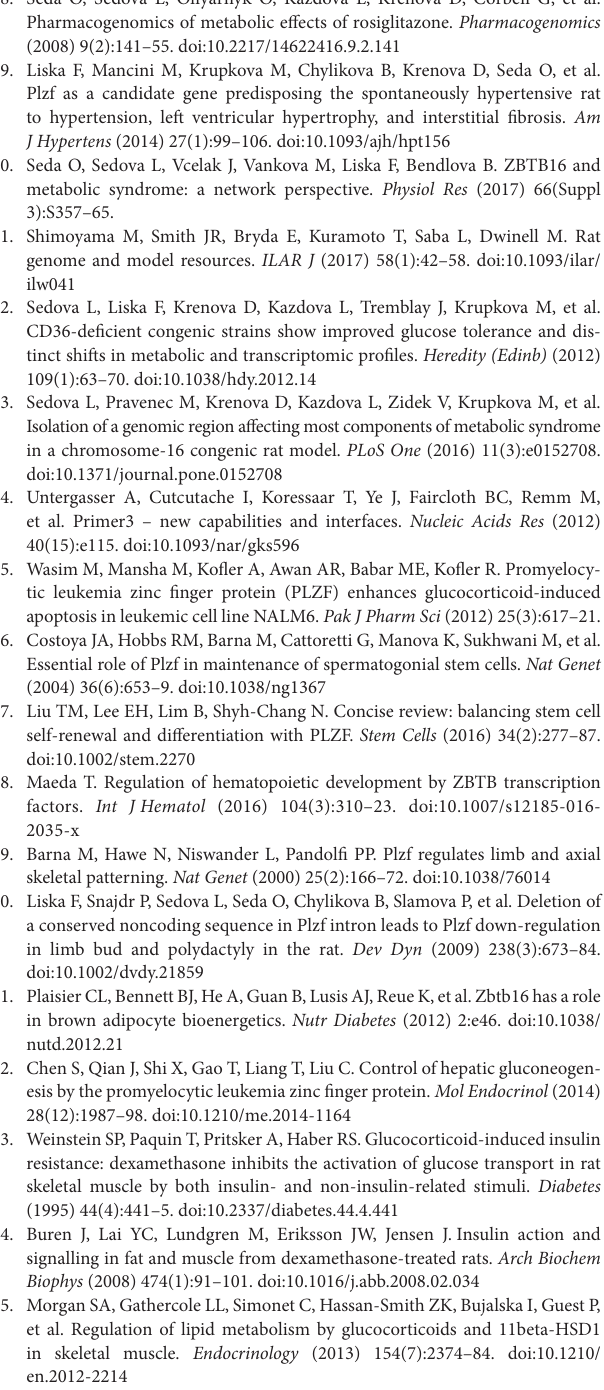
FigUre s1 | Representative genotyping results. The results of electrophoretic separation of polymerase chain reaction products of polymorphic markers are shown for individual rat strains (primer sequences and genomic positions of individual markers are shown in Table S1 in Supplementary Material) as follows: lane 1: ladder; lanes 2–4: PD/Cub; lanes 5–7: SHR- Lx .PD5; lanes 8–10: SHR- Lx .PD5 PD- Zbtb16 ; lanes 11–13: SHR- Lx .PD5 SHR- Zbtb16 ; lanes 14–16: SHR; and lane 17: negative